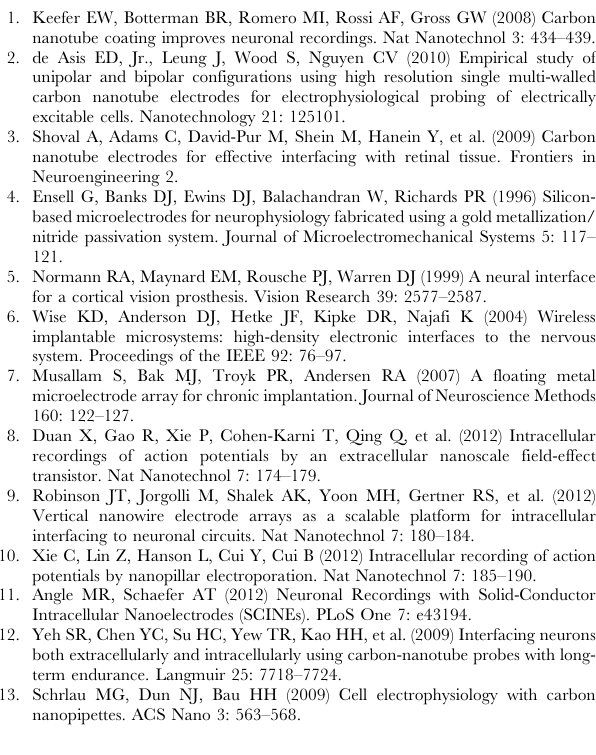
coating (no FIB). Left: Impedance over the frequency range of 1 to 100 kHz; Right: Nyquist plot of the same measurement. (TIF) Figure S2 Time evolution of intracellular recording (membrane potential (mV) vs. time (ms)). The recording is pseudo-continuous by repeating 2.5 second recording and 3.4 second gap. The figures show typical time evolution of a recording (t in each figure is starting time in seconds). (TIF) Figure S3 Action potential time course during intracel- lular recording. (A) Magnitude of Action Potentials (mV, peak value – membrane potential). (B) Full width half maximum of action potentials (ms). Data points are sampled over recording period for each cell.